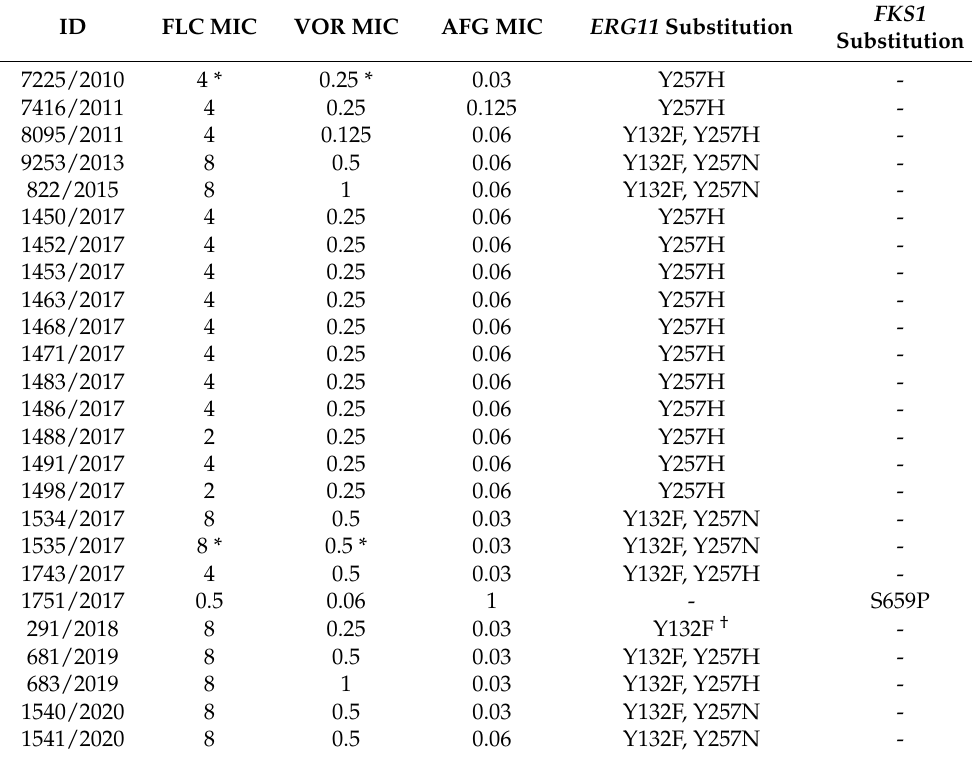
Table 2. Overview of isolates resistant or intermediately resistant to azoles or echinocandins with corresponding ERG11 or FKS1 substitutions. MIC, minimal inhibitory concentration; FLC, fluconazole; VOR, voriconazole; AFG, anidulafungin. ID FLC